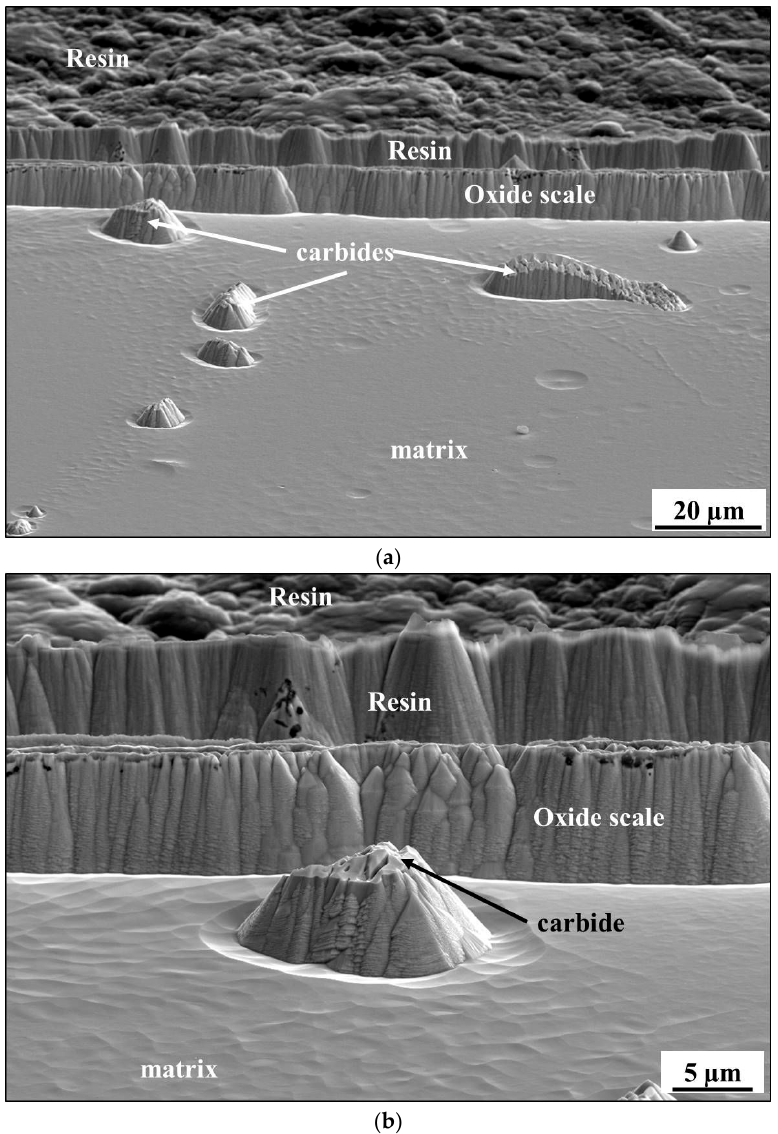
Figure 12. SEM/BSE images of the bottom of the sputtered area on the cross-section of CM247 after air oxidation at 1050 °C for 20 h showing: ( a ) an overview of the crater bottom, ( b ) single carbides and ( c ) carbides located at the grain boundaries of CM247.